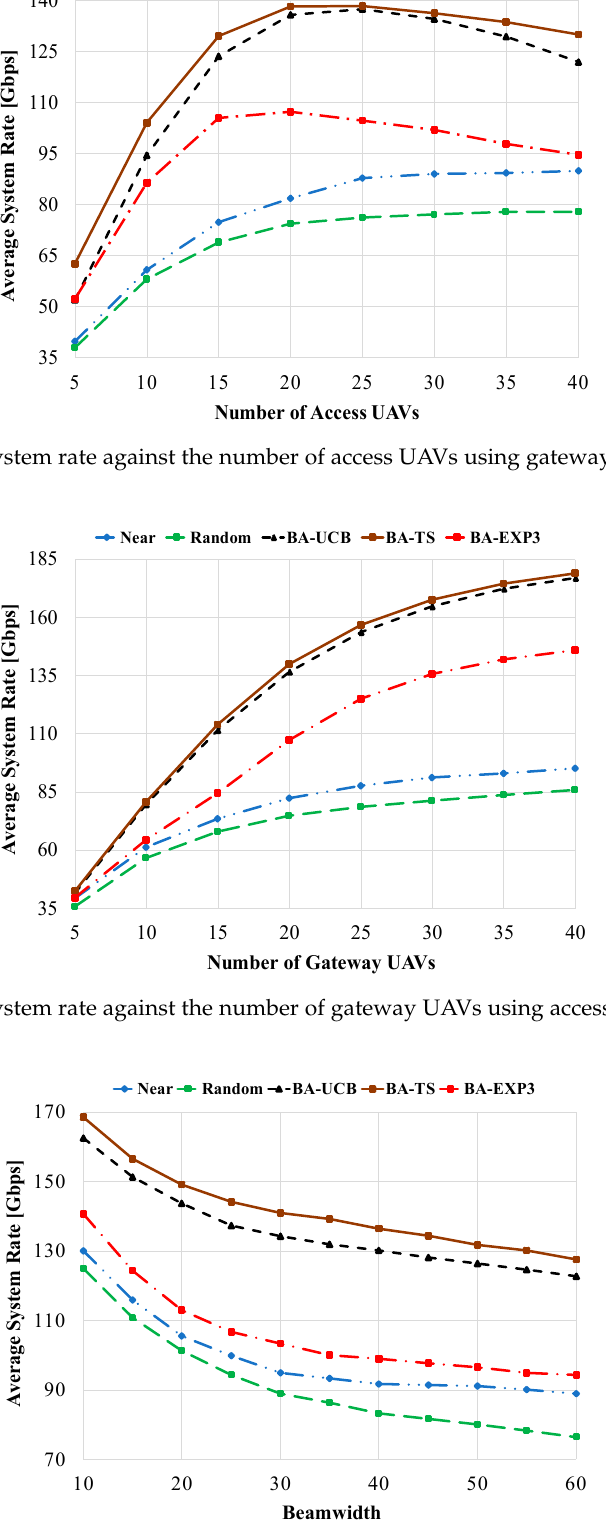
Figure 6. Average system rate against beam-width using access UAVs of 40 and gateway UAVs of 20.